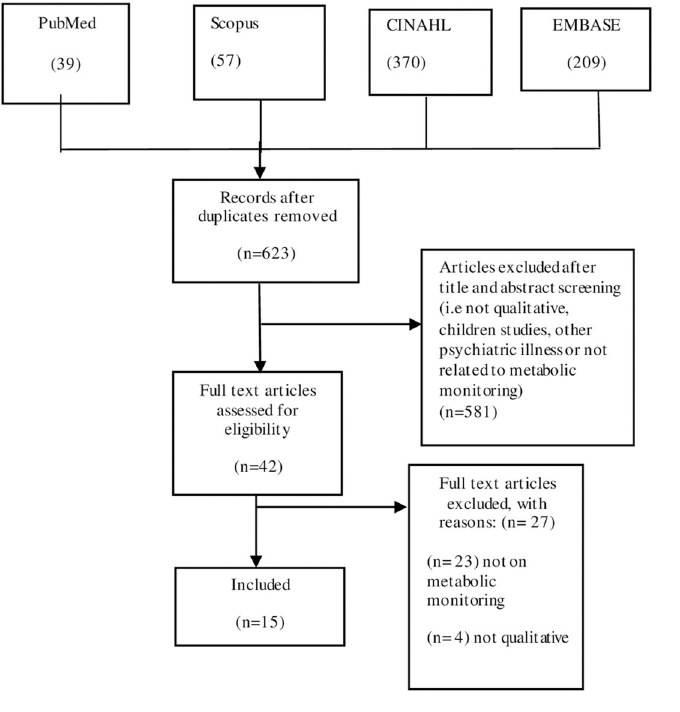
Fig 1. PRISMA flow